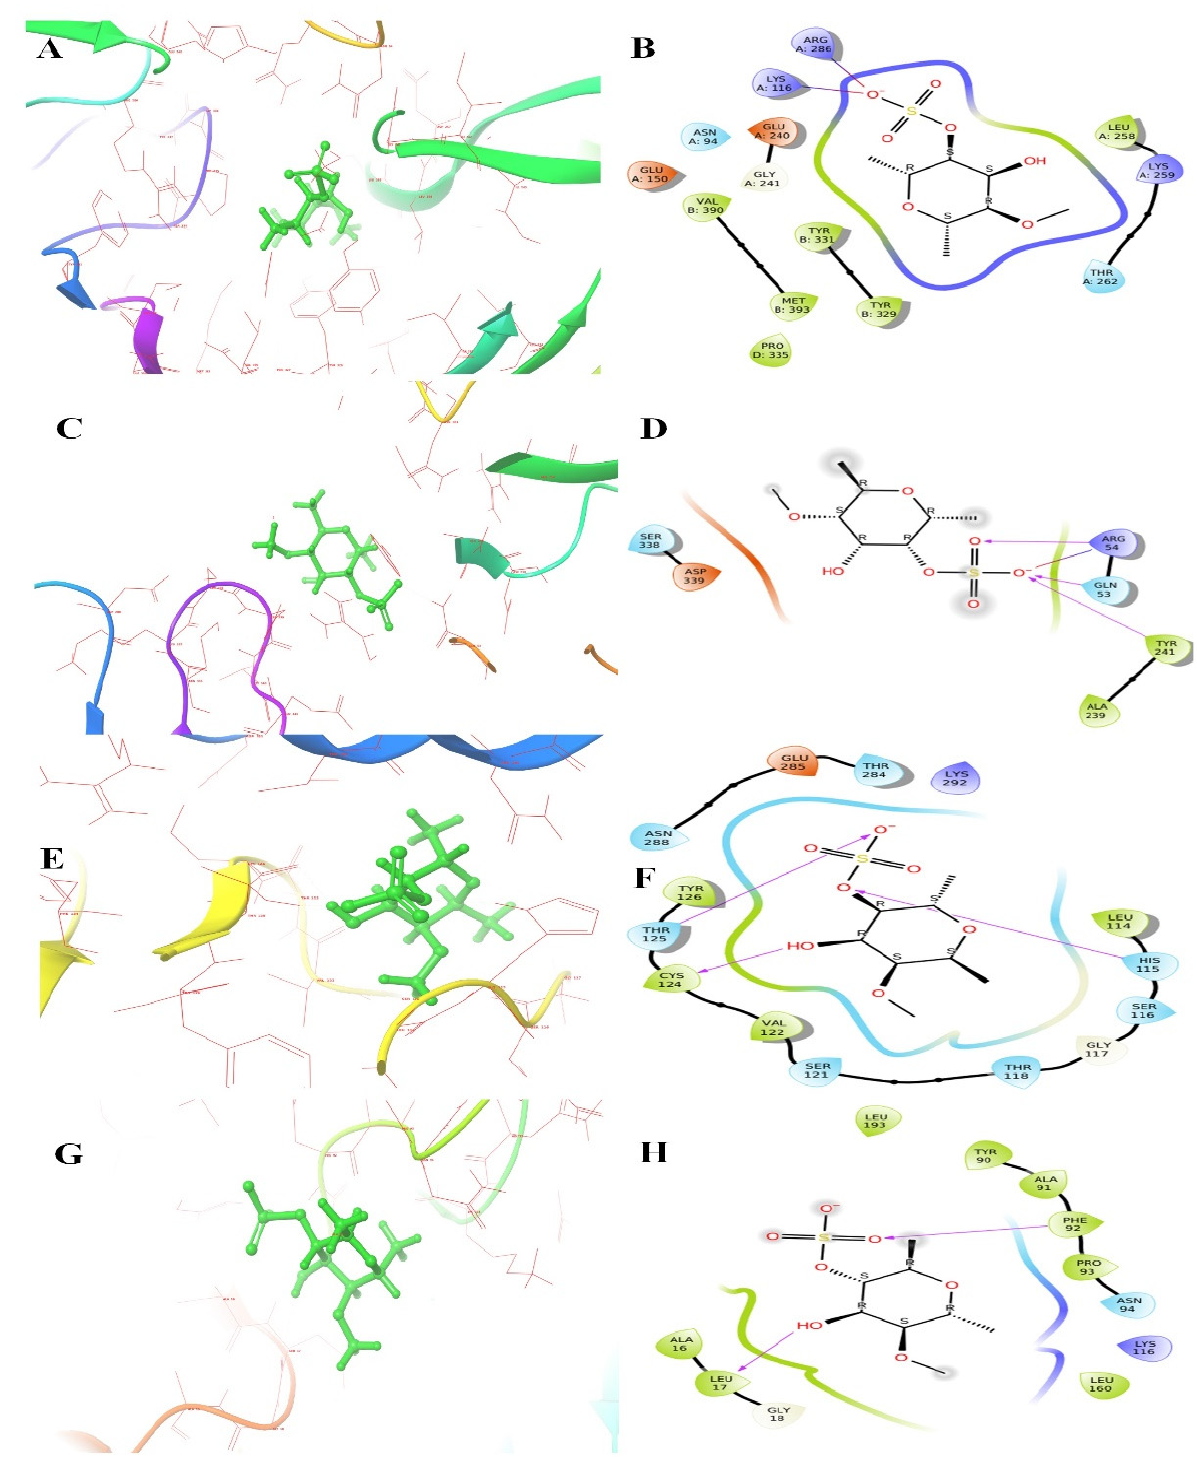
Figure 12. The three-dimensional and two-dimensional structures of docked compound (fucoidan) with antioxidant target proteins were represented as caspase-3 ( A , B ), nuclear factor NF-kappa-B p105 subunits ( C , D ), cellular tumor antigen p53 ( E , F ), and mucosal address in cell adhesion molecule 1 ( G , H ). The interaction was observed as hydroxyl and epoxy group of fucoidan.